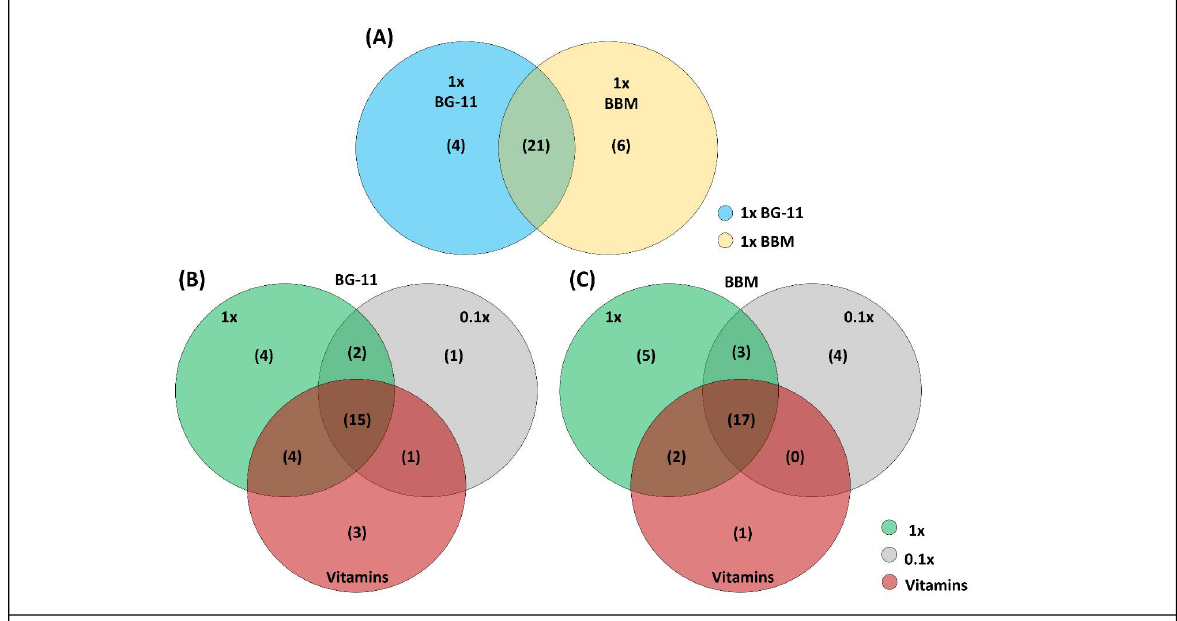
Figure 3. Venn diagram illustrating the shared/unique species between the tested conditions: normal media concentration (1 × media), reduced nutrient media (0.1 × media), and media enriched with vitamins (Vitamins). (A) Venn diagram summarizing the number of species identified using the standard BG-11 and BBM media only, (B) Venn diagram for the shared and unique species identified using BG-11 media and the three tested conditions, (C) Venn diagram for the shared and unique species identified in all tested BBM conditions.